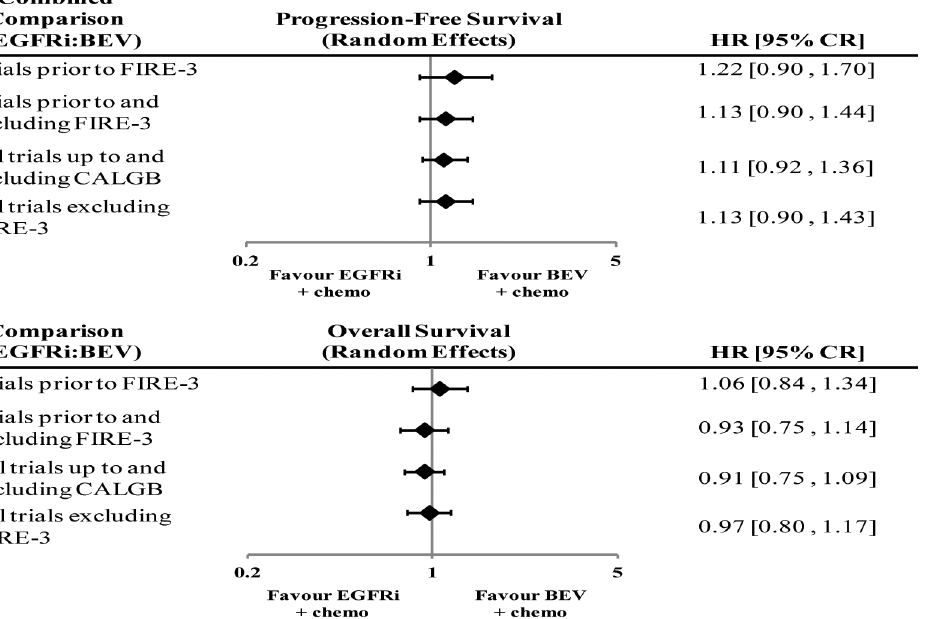
Fig 6. Forest plots showing hazard ratios for calculated from combined comparison of: trials prior to FIRE-3, trials up to and including FIRE-3, all trials up to and including CALGB, all trials excluding